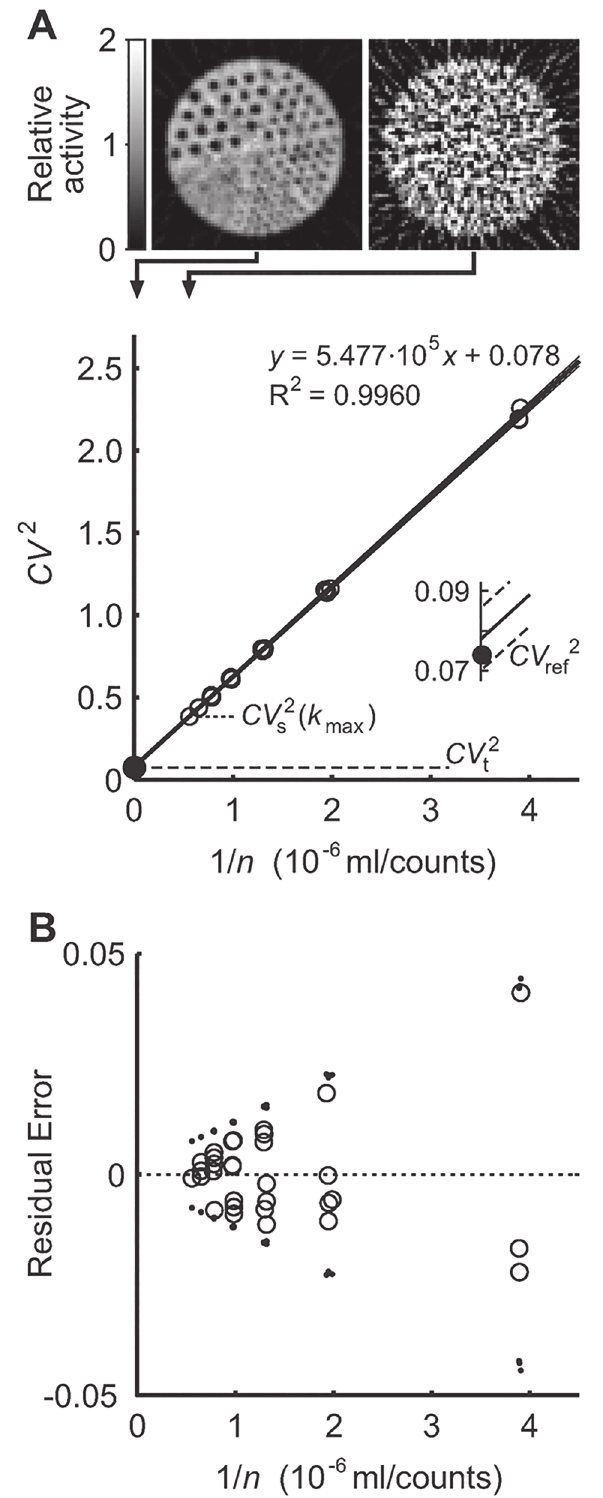
Fig 1. Estimation of noise-free heterogeneity and evaluation using a PET emission scan of a Jaszczak phantom filled with a solution of 18 F-FDG and water. A : The CV s2 ( k ) data ( (cid:5) ) for the linear regression